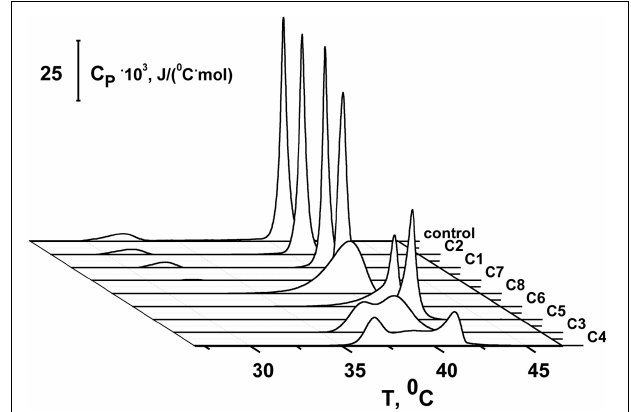
FIGURE 3 | Heating DSC thermograms of DPPC liposomes in the absence ( control ) and presence of 1,3-thiazine (C1 and C3), 1,2,3,4-dithiadiazole (C3 and C4), and thiohydrazide derivatives (C5–C8) at a lipid:compound molar ratio of 10:1.